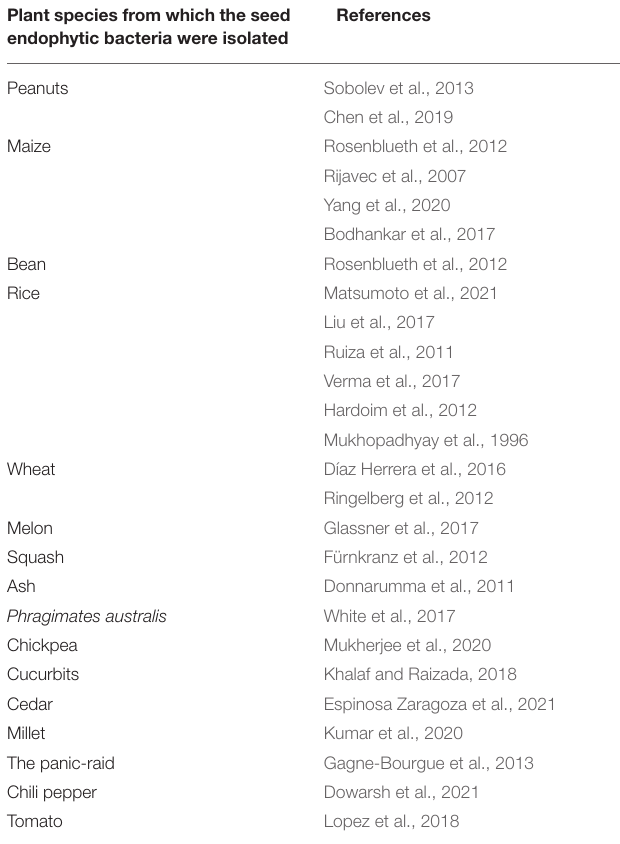
TABLE 3 | Summary table of publications recording the potential of biocontrol of seed endophytic bacteria isolated from several cultivated plant species. Plant species from which the seed endophytic bacteria were